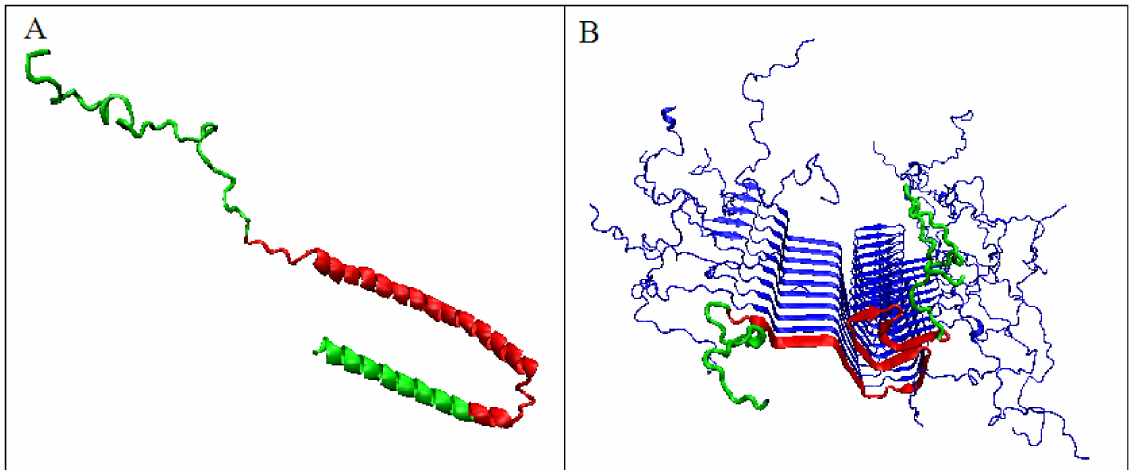
Figure 8. 3D presentation of α -synuclein. ( A )—Micelle-bound form, red fragment distinguished to show the fragment building the amyloid form of this protein; green fragments do not participate in fibril formation. ( B )—Amyloid form, red fragment – amyloid form, green fragments – not participating in the construction of